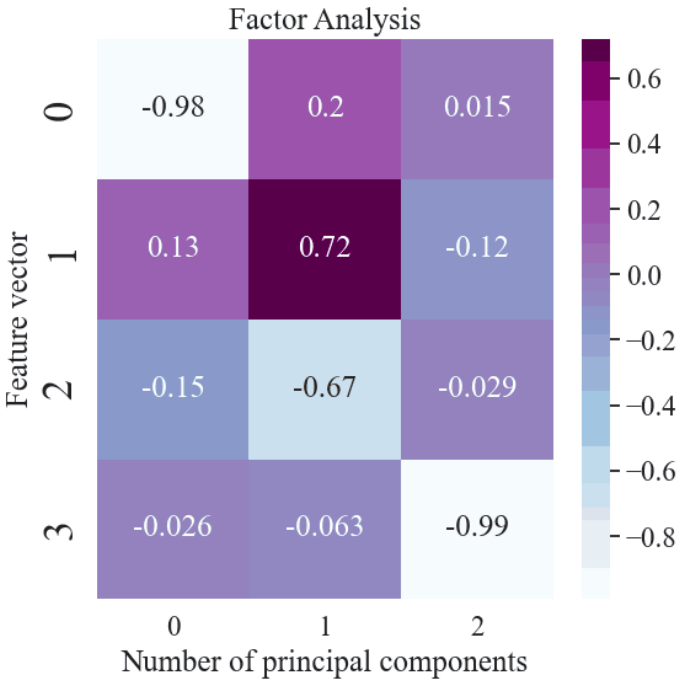
Figure 11. Eigenvector matrix corresponding to principal components.